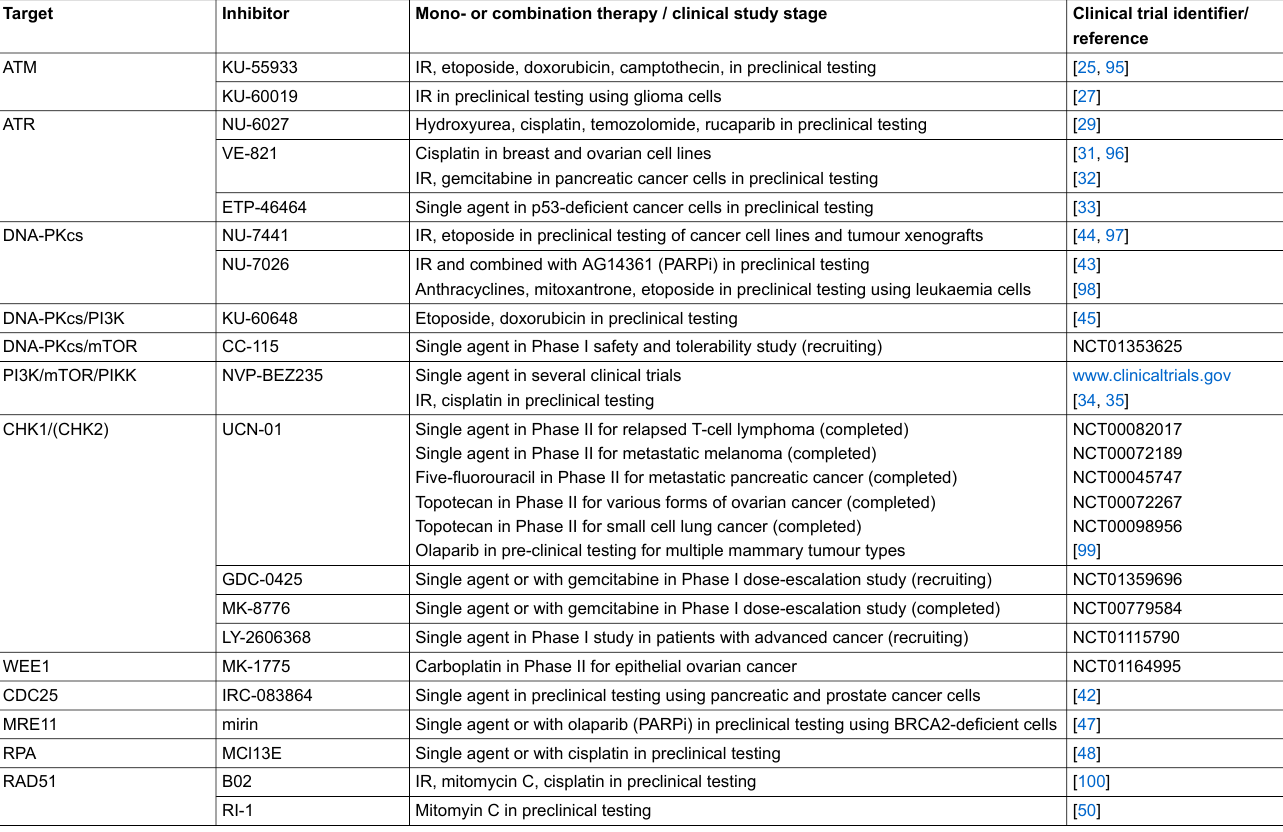
Table 1: Small molecule inhibitors of DNA damage response factors in preclinical or clinical development for cancer therapy.